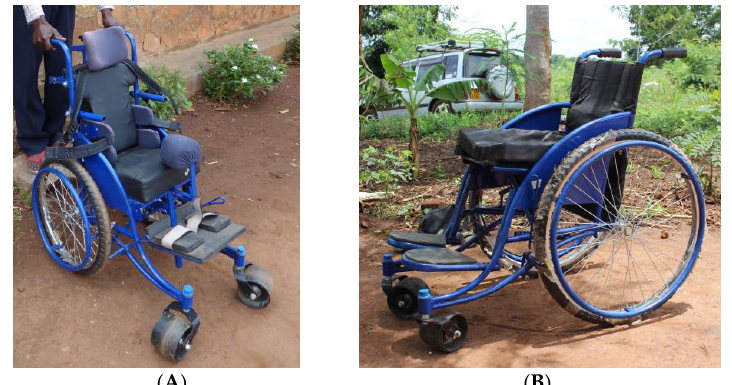
Figure 3. The two different types of wheelchairs used in the program: ( A ) Extra support model with a headrest, five-point harness, and extra supportive footrests and ( B ) regular model.